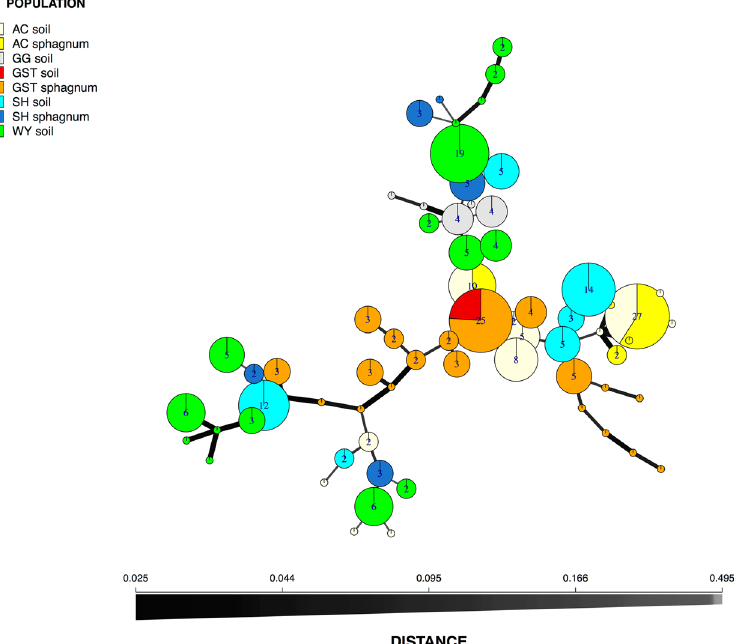
Figure 3. Minimum spanning network showing the relationship between individual SSR multilocus genotypes (MLGs) for Tulasnella prima observed in isolates collected in Kosciuszko National Park, NSW from Chiloglottis plants growing in soil or sphagnum hammocks. Each node represents a different MLG. Node sizes and colours correspond to the number of individuals and membership, respectively. The number of individuals per MLG greater than one is provided. Edge thickness and colour are proportional to absolute genetic